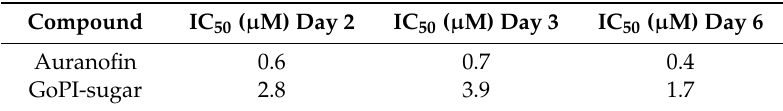
Table 4. IC 50 data of auranofin and GoPI-sugar for adult female Brugia pahangi worms using the worminator in vitro motility assay. Each compound was tested using a six-point serial dilution, n = four worms per concentration; R 2 ≥ 0.7 for all IC 50 s.